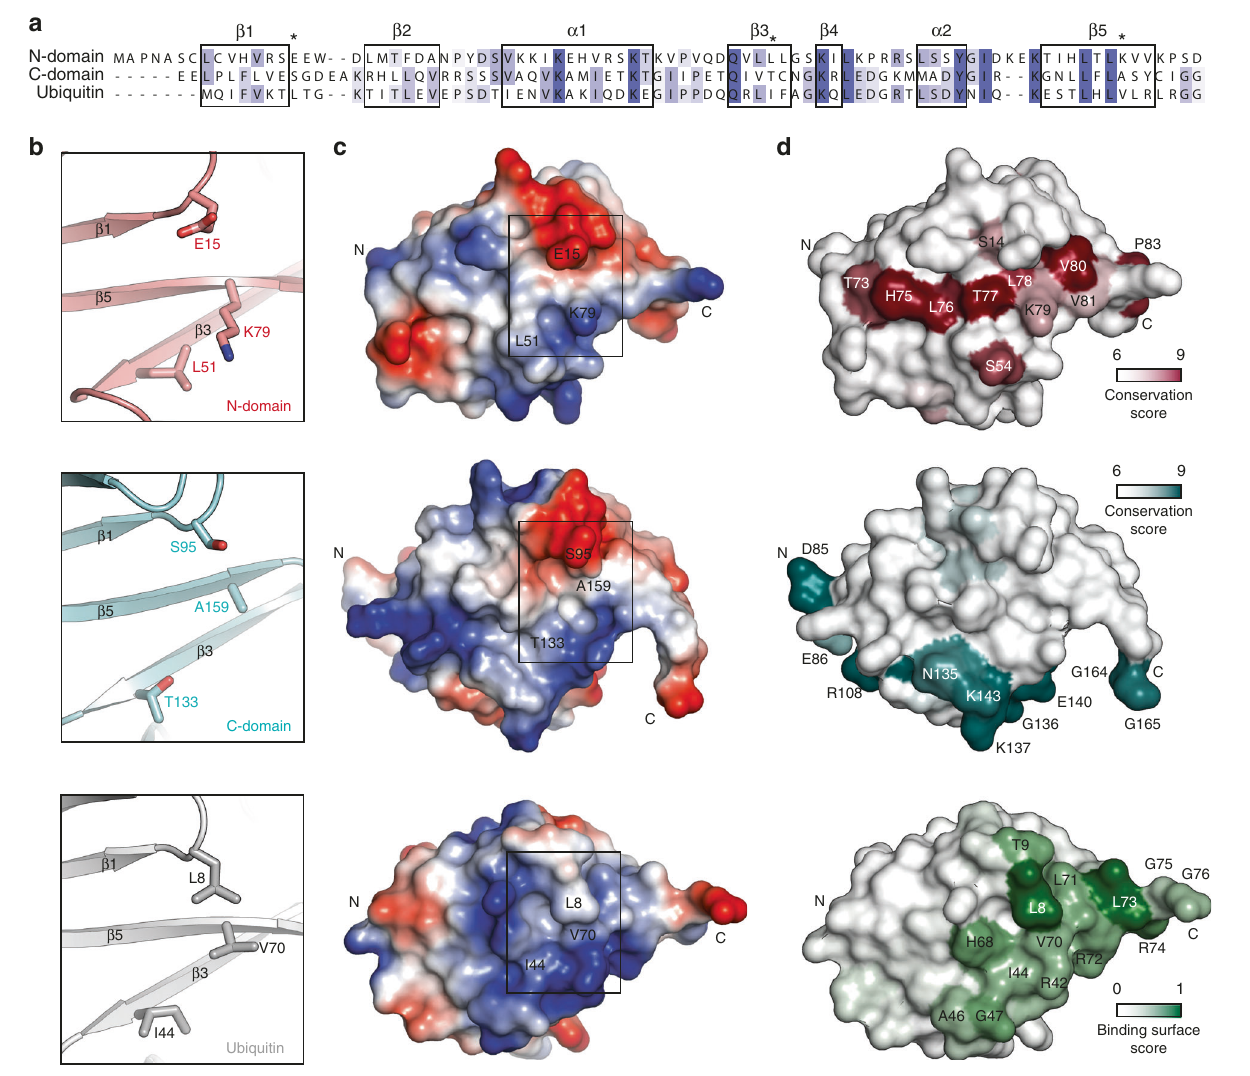
Fig. 2 The surfaces of the FAT10 UBDs are distinct from Ub and each other. a Structure-based sequence alignment of the human FAT10 domains with Ub. Residues are color coded by sequence identity from white (0%) to dark blue (100%). Secondary structure elements are labeled and boxed. The residues corresponding to the hydrophobic patch in Ub are marked with asterisks. b Close-up on the residues equivalent to the hydrophobic patch in Ub showing the N-domain (top), the C-domain (center), and Ub (bottom). c Electrostatic surface potentials of the FAT10 N- (top) and C-domains (center) and Ub (bottom). Negatively charged areas are colored in red, while positively charged regions are in blue and neutral residues in white. The position of the hydrophobic patch residues in Ub and equivalent positions in the FAT10 domains are labeled. The boxes outline the close-up regions depicted in b . d Surface plots of the FAT10 N- (red; top) and C-domains (teal; center) colored by conservation of residues in mammalian FAT10 proteins (Supplementary Fig. 4). Highly conserved residues are labeled. The surface of Ub is color coded in green by occurrence of residues at the interfaces of Ub – protein complexes (bottom). All structure and surface representations are in the same orientation as in Fig. 1d –